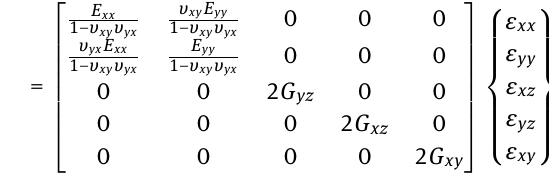
Figure 1: Schematic of the X-Z and Y-Z views of Graphene reinforced